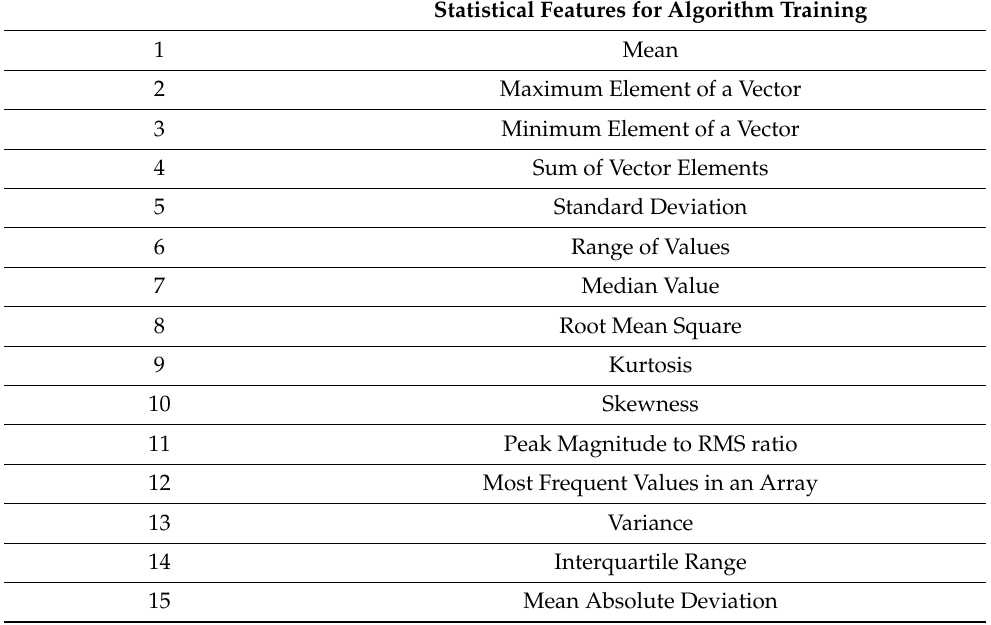
Table 1. Statistical Features Extracted for Training Machine Learning Algorithms. Statistical Features for Algorithm